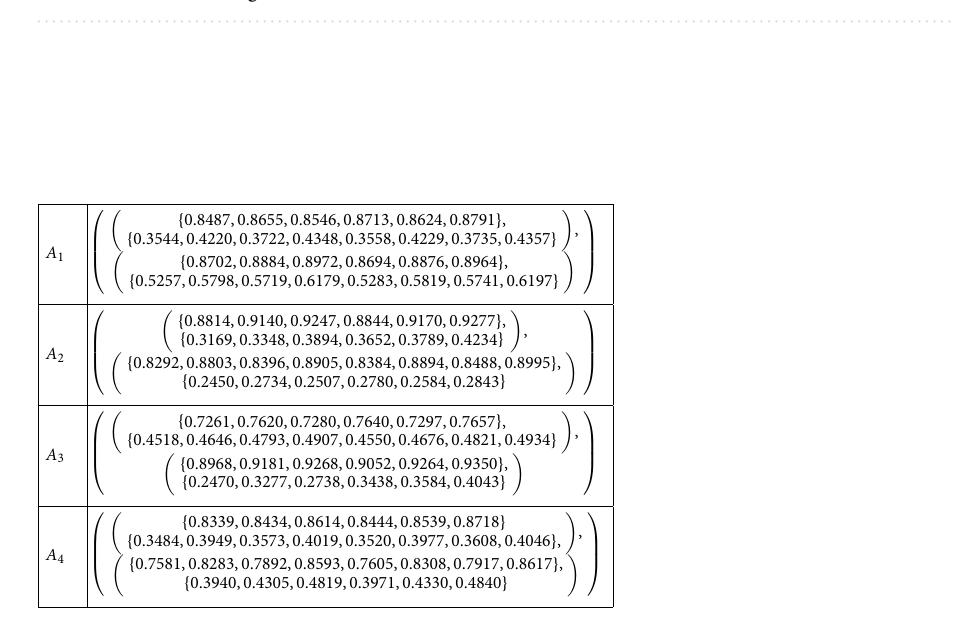
Table 13. Aggregated information using q